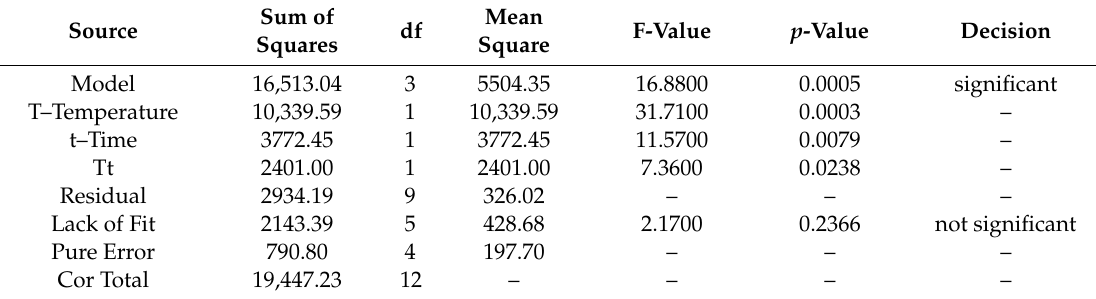
Table 3. ANOVA for the two-factor interaction model of conductivity.